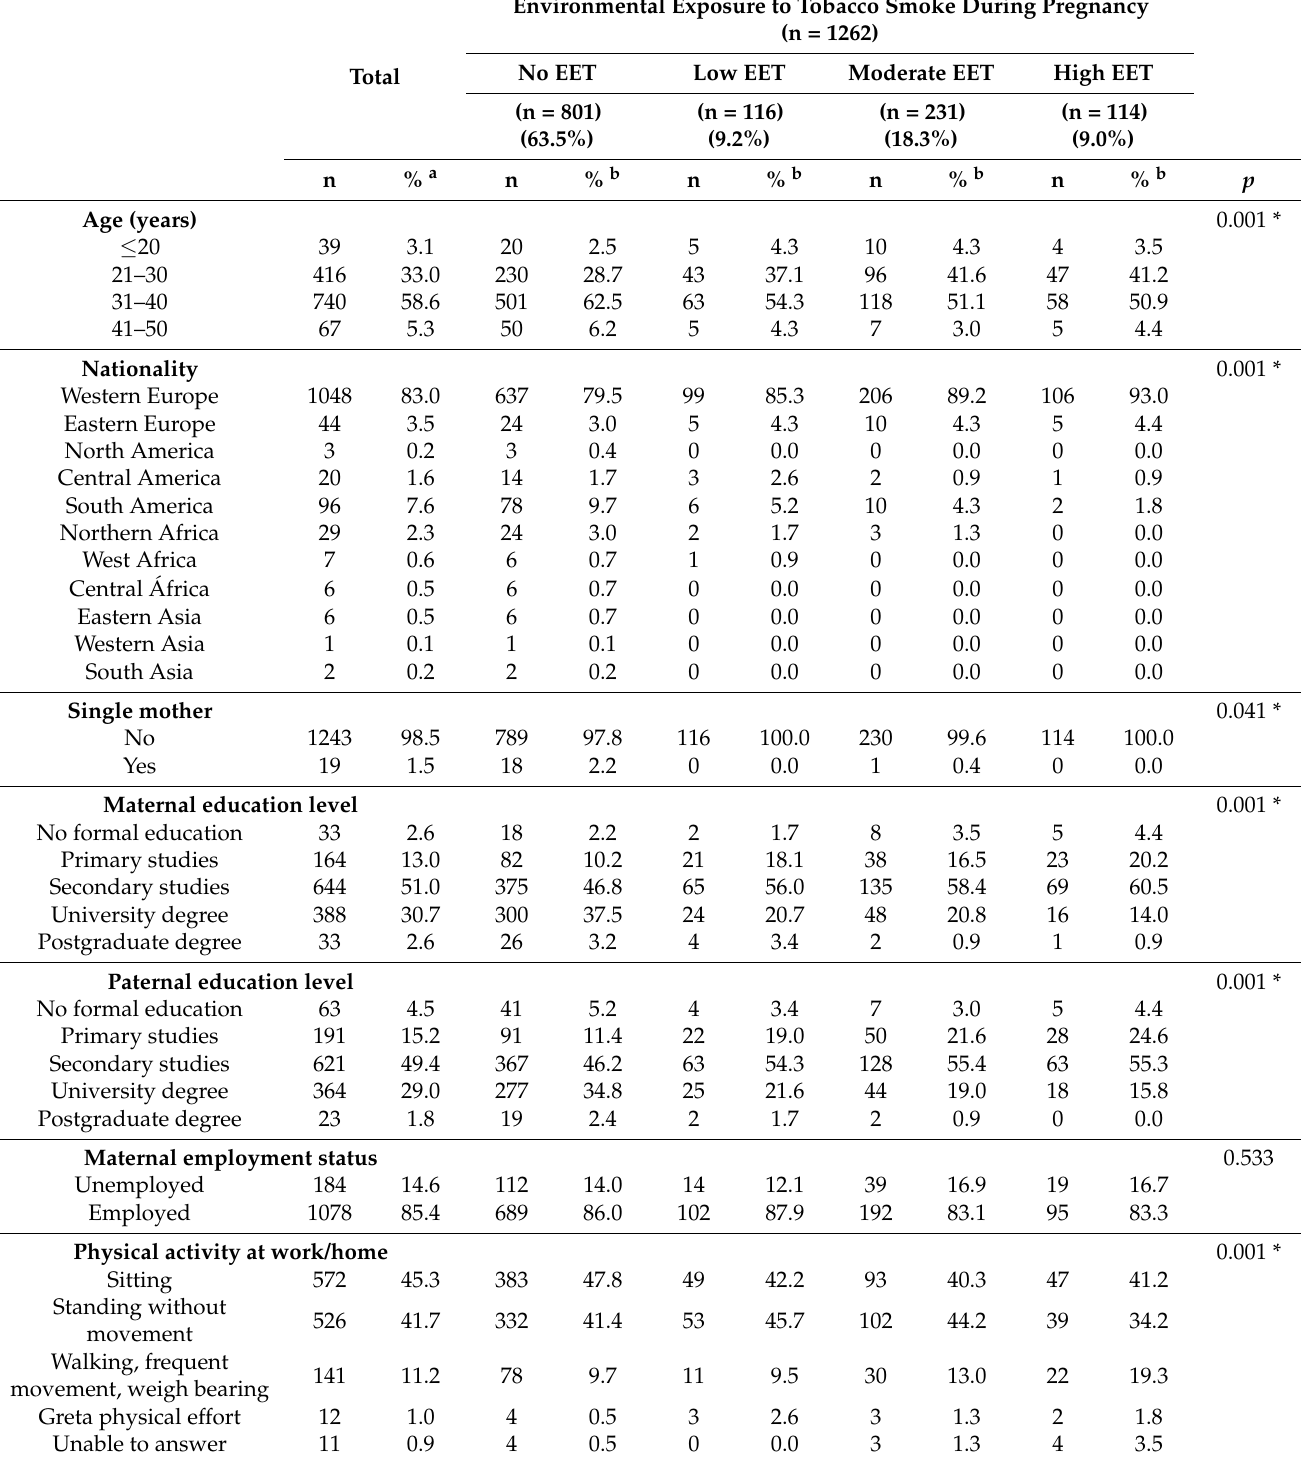
Table 3. Sociodemographic characteristics of the women included in the